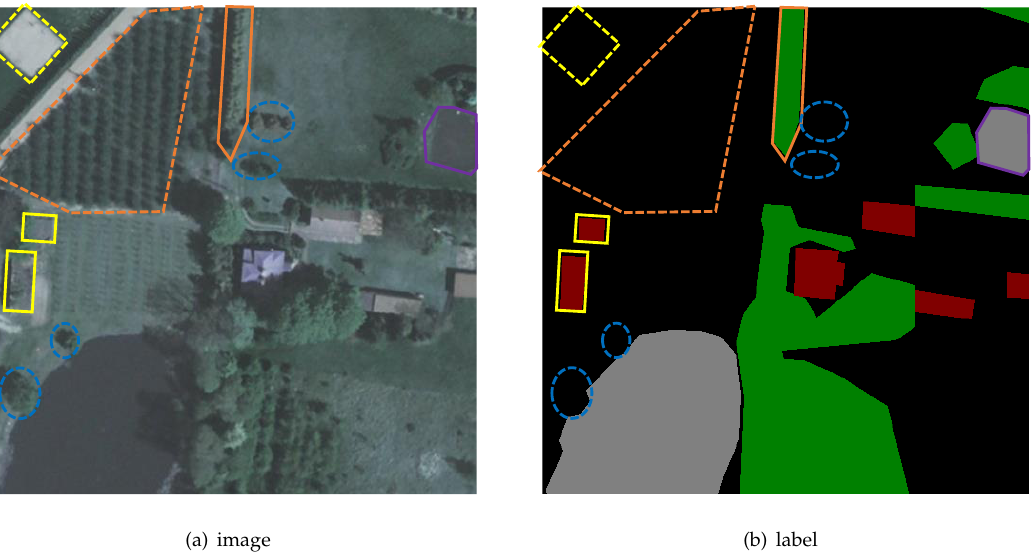
Figure 5. An example for LandCover dataset. ( a ) The original image; ( b ) Manually annotated label. The parts shown by the dotted line belong to the background class while they are easy to be misclassified. The objects circled by the solid line are the target classes while they are easy to recognize as